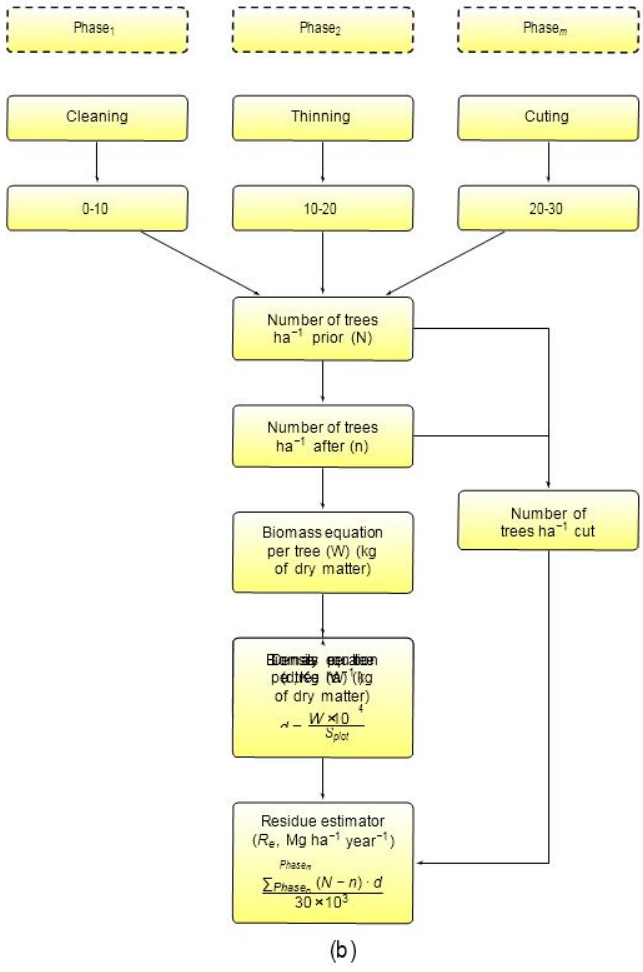
Figure 5. Methodological diagram for determining forestry residue. ( a ) E. globulus ; ( b ) P. radiate .